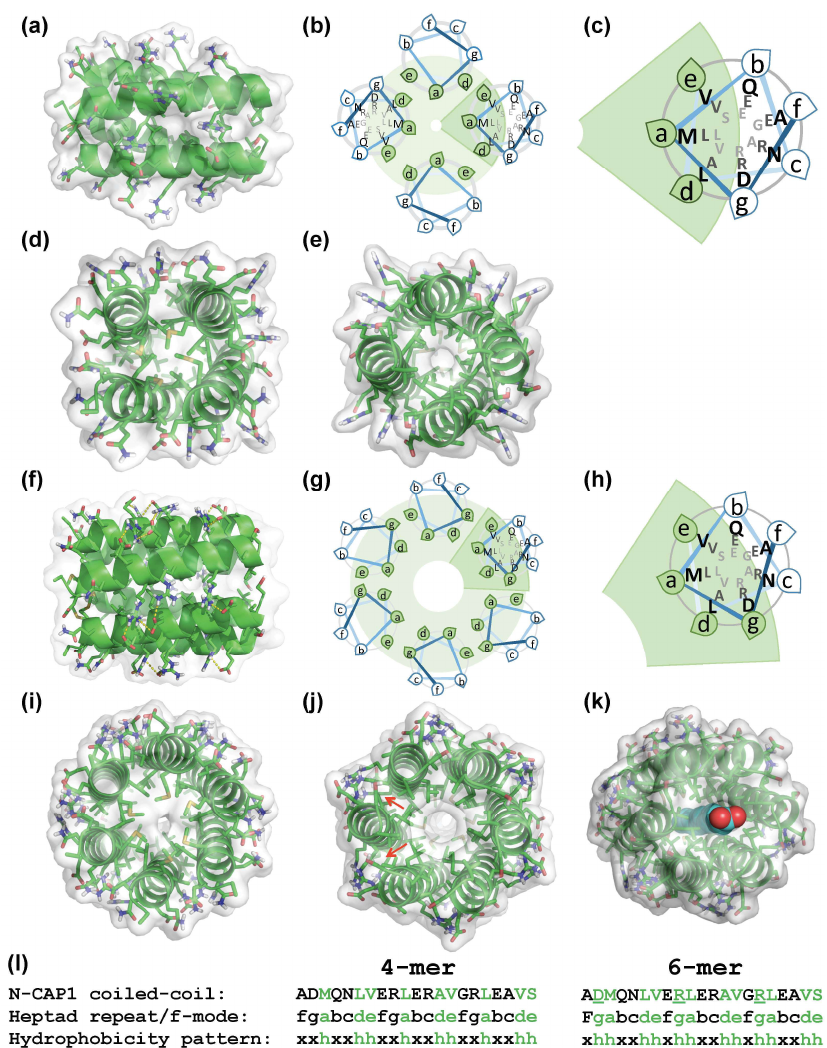
Figure 3. Modeling oligomerization of the N-terminal constructs of human CAPs: the CCBUILDER 2.0 web application (http://coiledcoils.chm.bris.ac.uk/ccbuilder2) was used to model the oligomeric coiled-coil structures of CAP1 (shown) and CAP2 N-terminal helices. The most stable tetramers ( a – e ) and hexamers ( f – j ) with the lowest energies are shown from three perspectives: side view ( a , f ), and along the helices from the N- ( d , i ), and C-termini ( e , j ). Schematic helical wheel diagrams show the relative orientations of the helices in the oligomers ( b , g ) and an enlarged view of the highlighted helices (c,h). Green shaded areas represent the hydrophobic cores of the oligomers. Up to four salt bridges between Arg and Asp/Glu residues contribute to the stabilization of each pair of neighboring helices (shown as yellow dotted lines in ( f )). ( k ) Hypothetical stabilization of the hexamer structure by a fatty acid (blue) occupying the central, hydrophobic channel of Srv2/CAP (see Section 3). A low-energy CAP2 structure generated in CCBUILDER is shown. (l) The N-terminal coiled coil sequence of CAP1 (top row), with the conventional “a–f” designation of the heptad amino acids (middle row) and the hydrophobicity pattern (bottom row) characteristic of trimeric/tetrameric (xxhxxhh) and higher-order (xhhxxhh) coiled-coil structures. Residues involved in stabilization of the hydrophobic cores are designated by “h” in the hydrophobicity pattern and by green color elsewhere. Notice that in the hexamer, Cβ-Cγ atoms of the underlined Arg residues (l) contribute to the stabilization of the hydrophobic core (red arrows in (j).